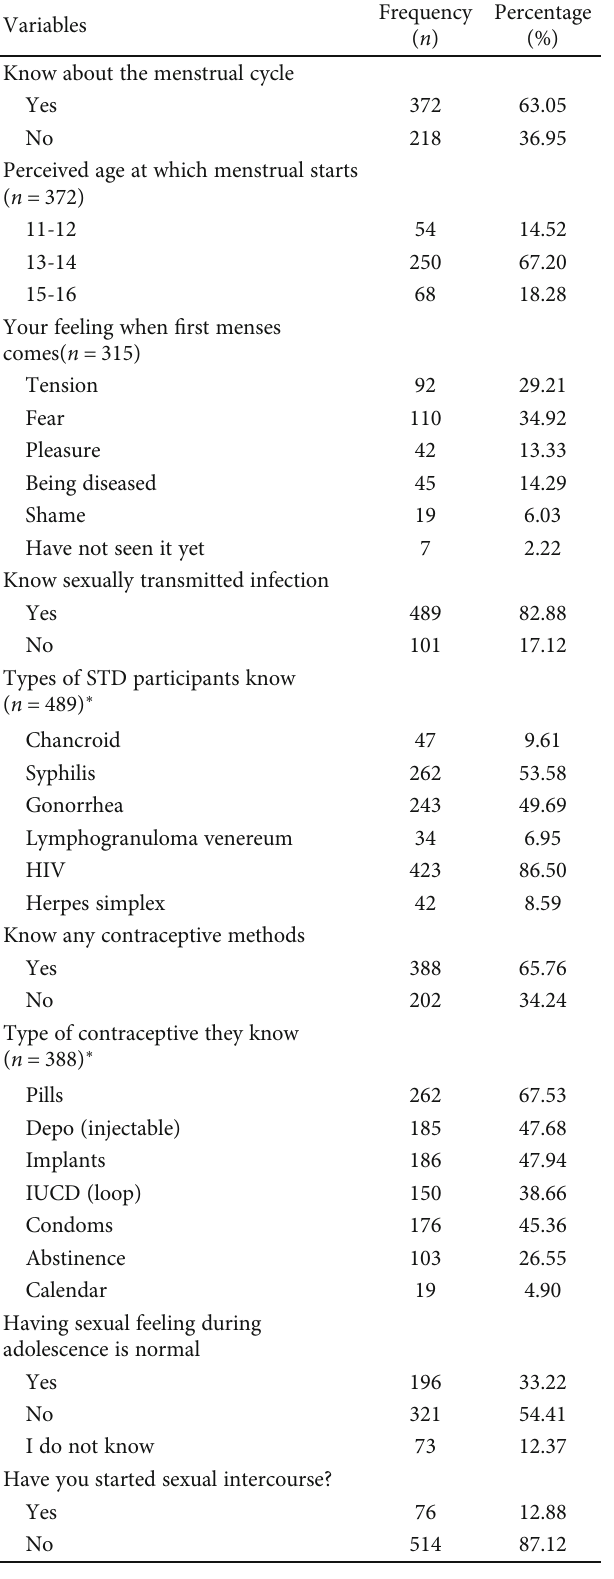
Table 4: Adolescent knowledge on SRH issues and sexual behaviors among secondary and preparatory school students in Ambo Town, Oromia region, Ethiopia,